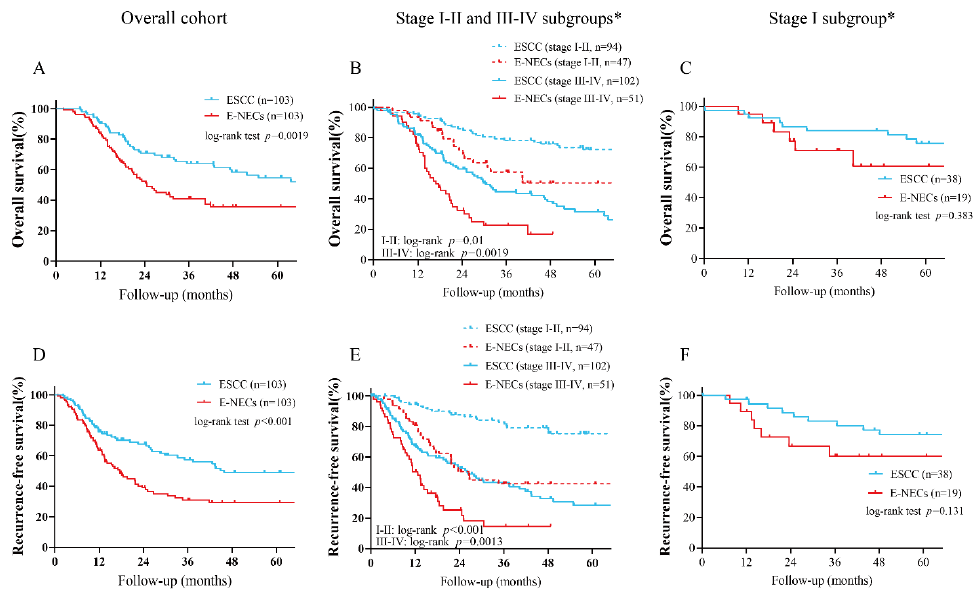
Figure 4. Kaplan–Meier analysis of OS and RFS for the overall cohort and subsets: ( A , D ) OS and RFS curves for the overall cohort; ( B , E ) OS and RFS curves of patients in the stage I–II and III–IV subgroups; ( C , F ) OS and RFS curves of patients in the stage I subgroup. Abbreviations: OS, overall survival; RFS, recurrence-free survival; E-NENs, esophageal neuroendocrine neoplasms; ESCC, esophageal squamous cell carcinoma. * The stage I, I–II, and III–IV subgroups were formed by the PSM with 1:2 ratio; namely, these 3 cohorts were generated from 3-times independent PSM.